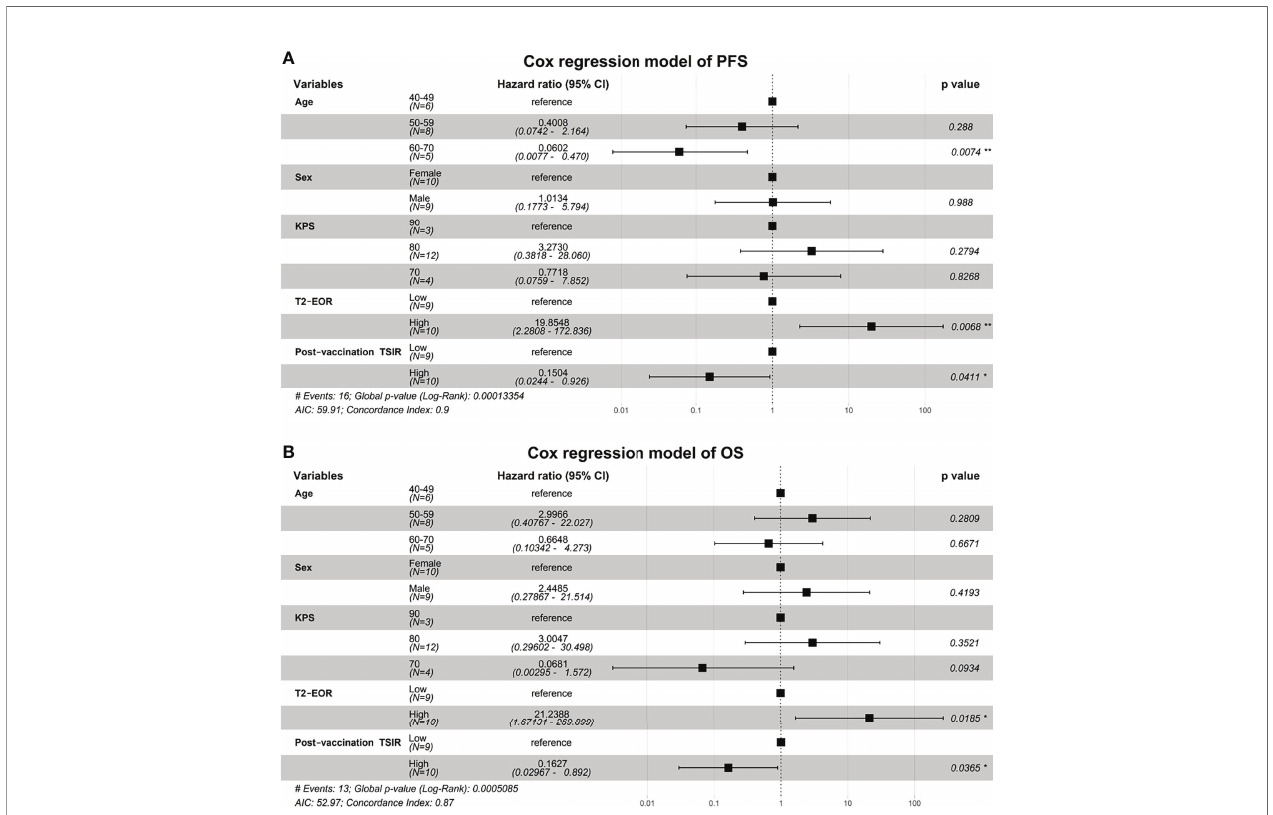
FIGURE 4 | High T2-EOR was an independent predictor associated with shortened PFS and OS times. Two Cox regression models were fi tted to identify independent prognosticators for (A) progression-free survival and (B) overall survival. *, P < 0.05. **, P <